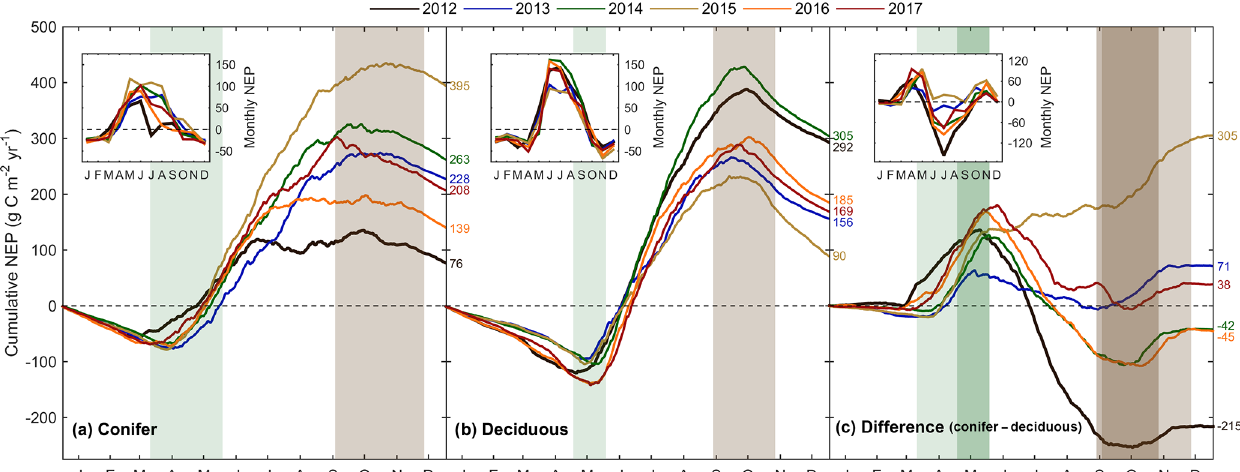
Figure 5. Cumulative daily sums of net ecosystem productivity (NEP) at (a) the conifer forest (TP39), (b) the deciduous forest (TPD), and (c) the cumulative difference (conifer – deciduous), with appropriate monthly NEP sums in each panel inset, from 2012 to 2017. Green shading in each panel corresponds to the site-specific 6-year mean phenological spring duration, while brown shading corresponds to the 6- year mean phenological autumn duration (Table 2). Dark shading in panel (c) represents the deciduous forest seasons overlaid on the conifer seasons. Cumulative annual values are shown for each site and year, with colors found in the